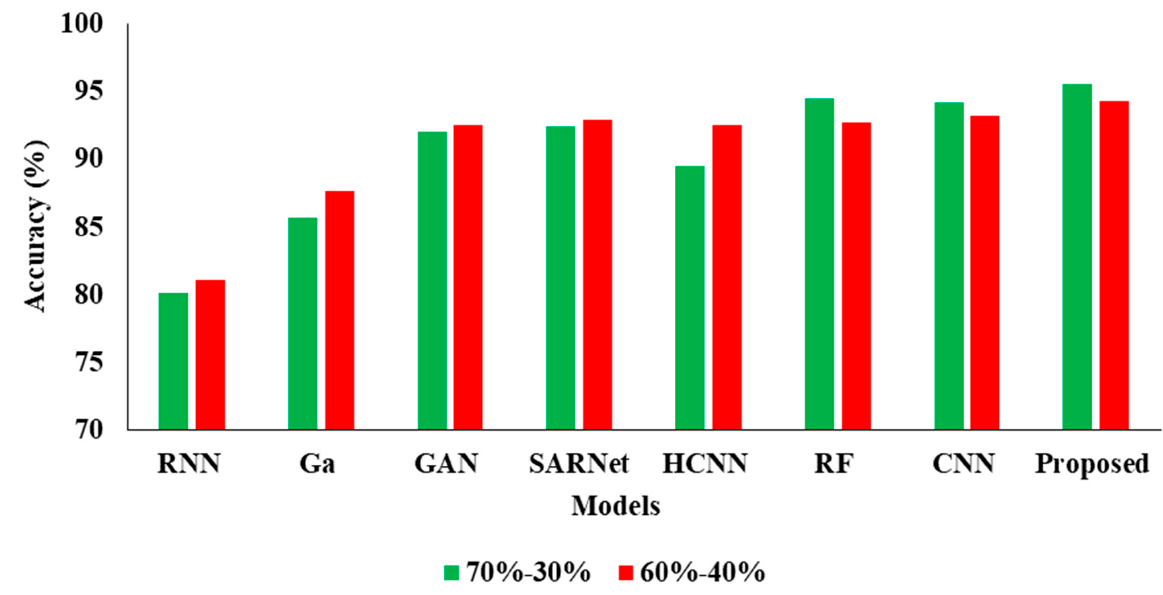
Figure 5. Accuracy Comparison for two data splits-ups. The Table 5 represents the Comparative Analysis of the Proposed Model. From these validations, it proves that the performance of the proposed model achieves better performance than other models. For instance, the proposed model training period is 390.33, and the execution time is 0.01128 (s),